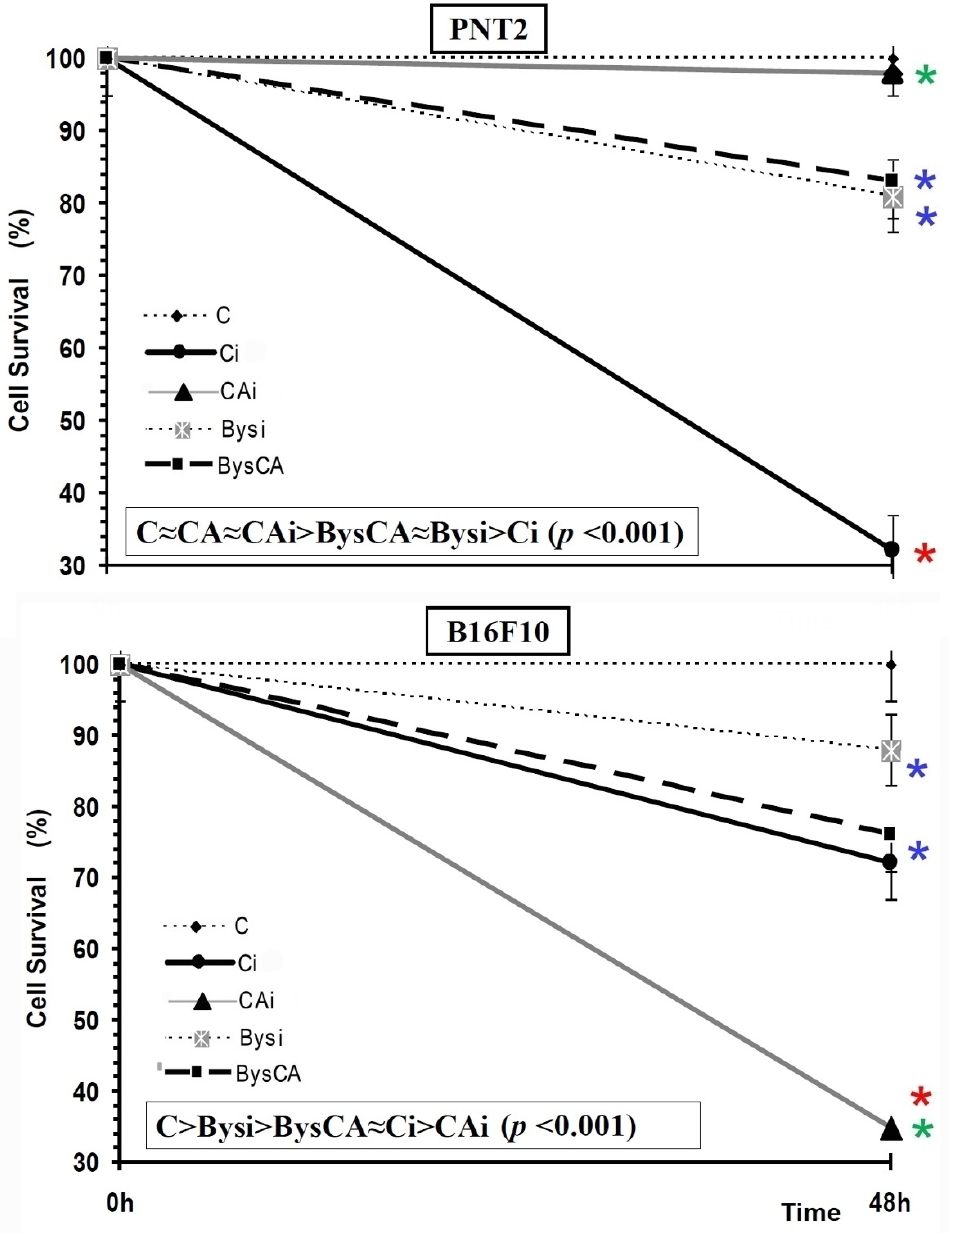
Figure 6. MTT assay: Cell survival of all groups studied in PNT2 and B16F10 (C, control; CA, treated with carnosic acid; Ci, irradiated control; CAi, irradiated previously treated with carnosic acid; Bys, treated with serum non irradiated; Bysi, treated with serum previously irradiated; BysCA, treated with irradiated serum previously treated with carnosic acid) ( * p < 0.001 versus C; * p < 0.01 versus C; * p < 0.001 versus Ci). Groups CA and Bys are not represented in the figure, since they coincide with group C. Data are mean ± SE of six independent experiments.